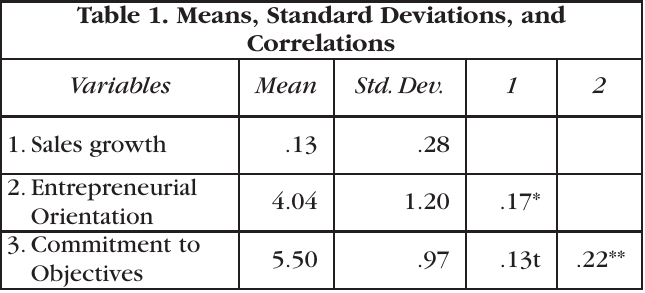
Table 1. Means, Standard Deviations,